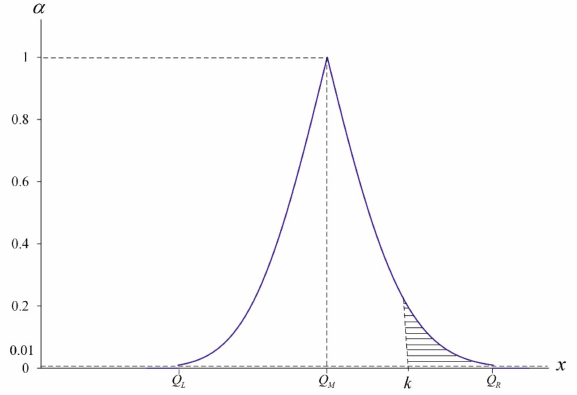
Figure 2. Membership functions of η ( x ) with x = k